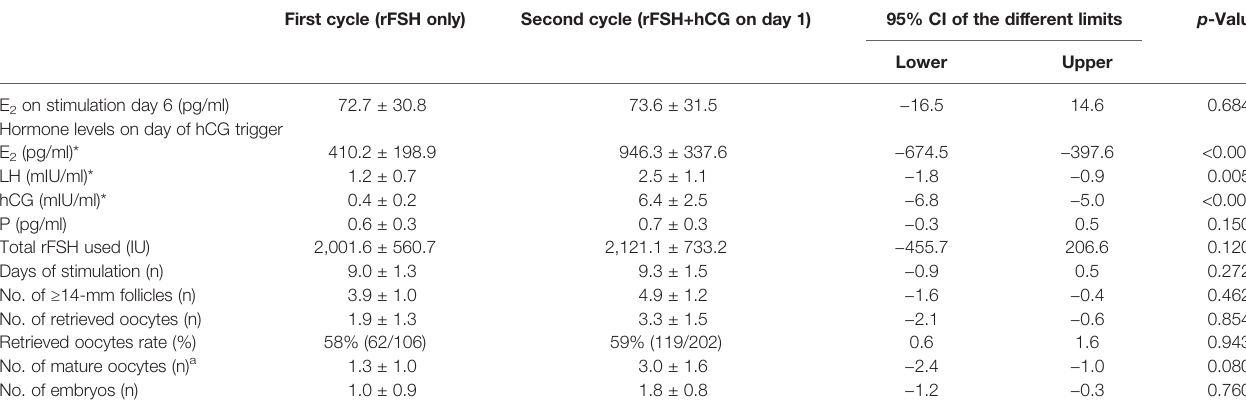
TABLE 3 | Self-comparison of OS characteristics in Group B (n = 32) with and without hCG addition. First cycle (rFSH only) Second cycle (rFSH+hCG on day 1) 95% CI of the different